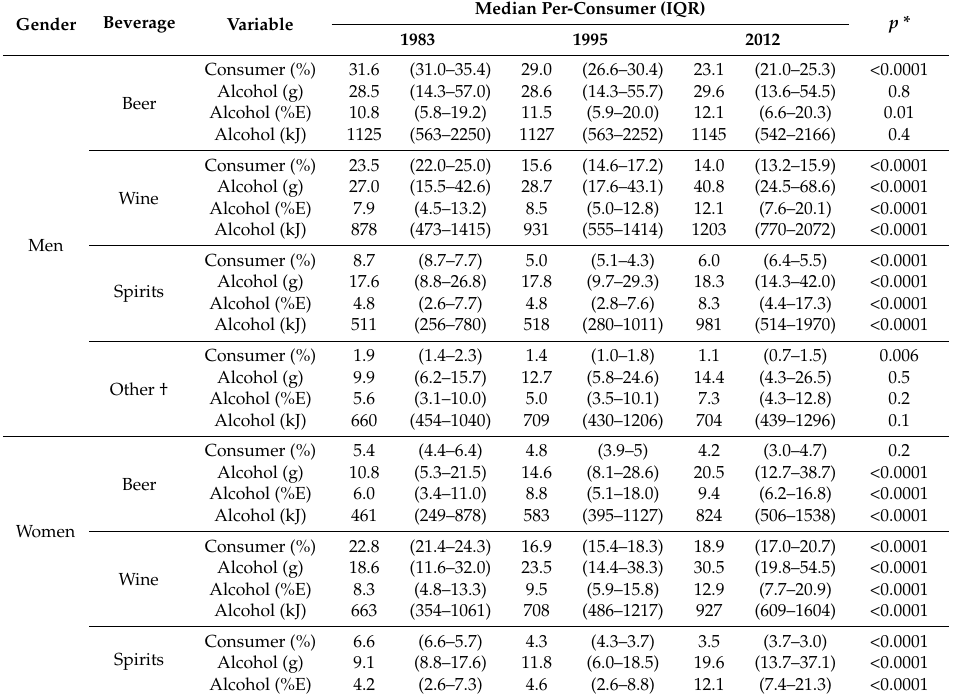
Table 4. Proportion of consumers (95% Confidence Intervals) and per-consumer median (IQR) alcohol (g), percentage energy (%), and total energy (kJ) from alcoholic beverages reported in the 1983 ( n =